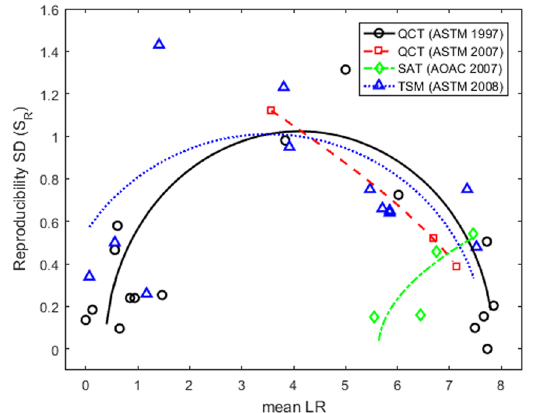
Figure 2. Reproducibility of methods that test sporicides. Results are shown from multi-laboratory studies of 3 different methods that test agents against B. subtilis spores. The number of labs and products tested in each study are given in Table 1. The regression curves approximate the reproducibility SD (S R ) as a frown-shaped function of the mean LR for each method. Each point corresponds to S R and the mean LR attained by a single agent in a multi-laboratory